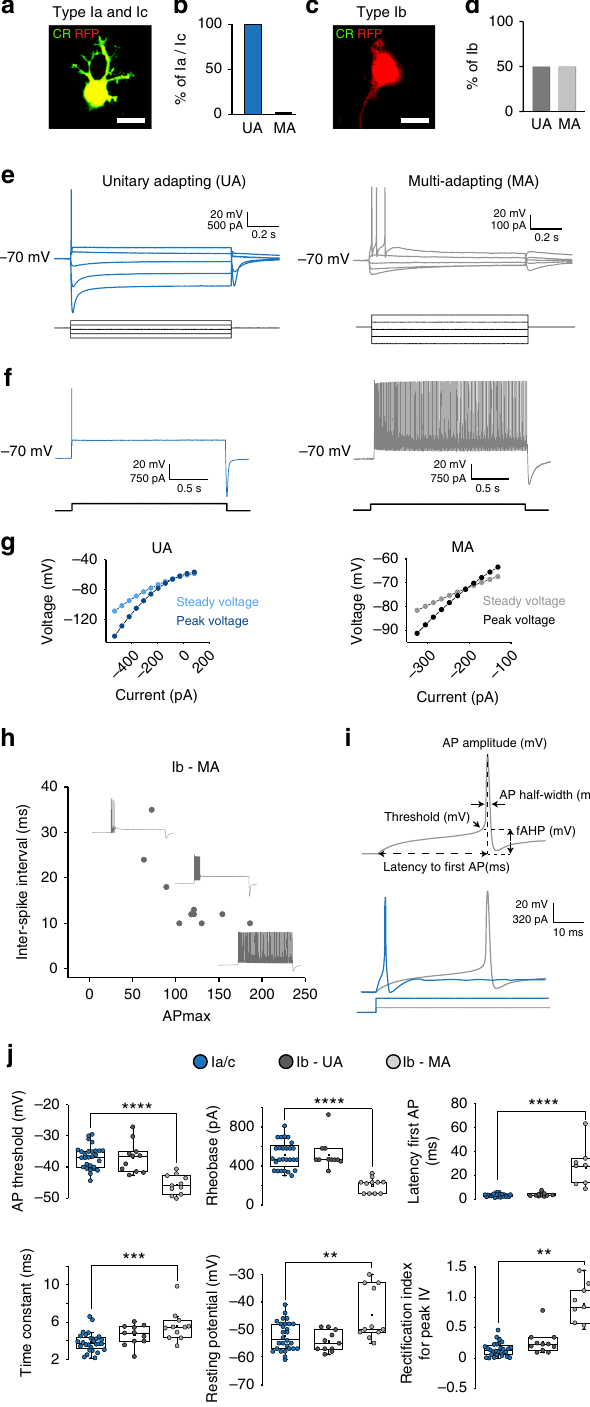
( Rab3a ) is essential for synaptic targeting and membrane fusion 27 . Their enrichment within the type I neurons group